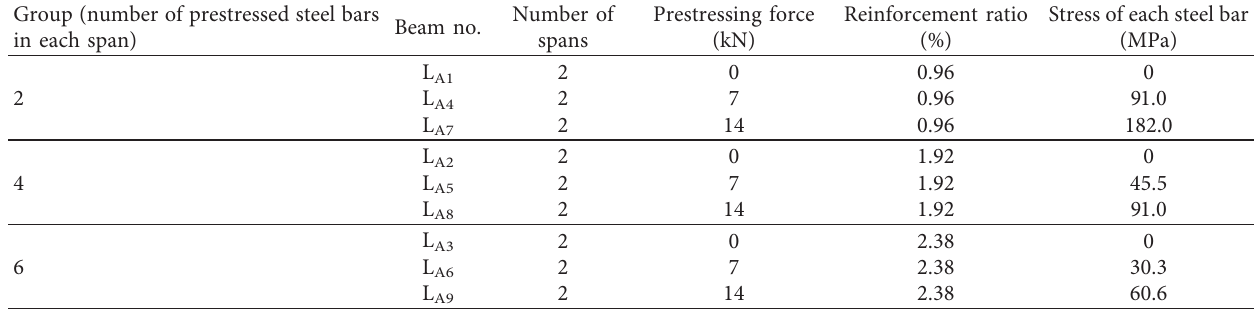
Table 2: Basic information of Group II.